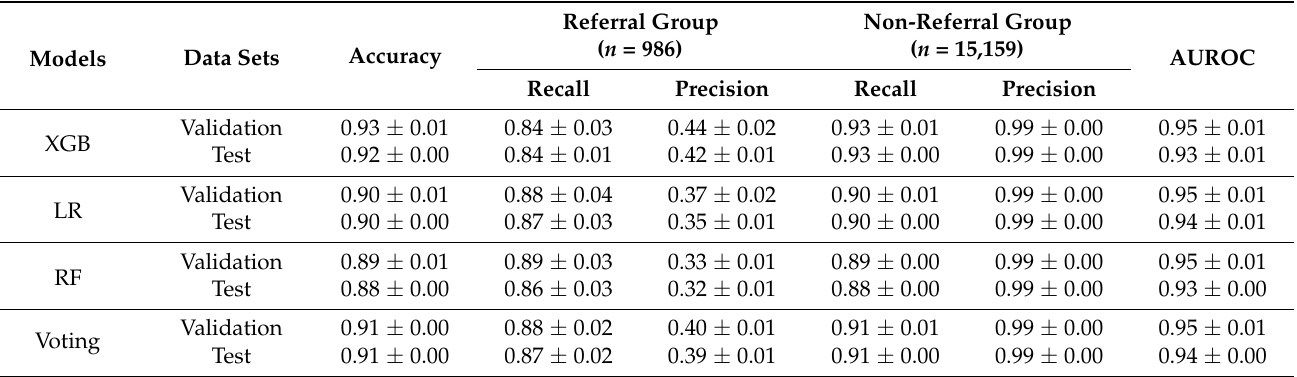
Table 4. Performance metrics for the three models to predict rapidly progressive kidney disease and nephrology referral when the eGFR was persistently < 45 mL/min/1.73 m 2 .